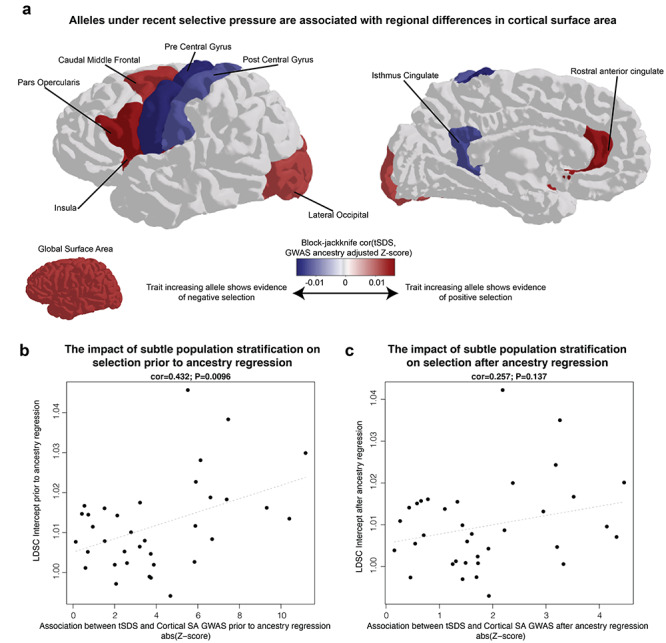
Evidence for haplotypes under recent polygenic selection (~2000–3000 years) impacting cortical structure. (a) A block-jackknife correlation of ancestry regressed effect sizes from GWAS (Z-scores) with scores of recent selection (tSDS) demonstrates evidence for polygenic alleles under selective pressure also influencing both global and regional SAs (colored regions indicate FDR < 0.05). Colder colors indicate that the trait increasing alleles (associated with increased SA) are generally associated with negative selection (decreasing allele frequencies in the population), whereas warmer colors indicate that trait increasing alleles are associated with positive selection. (b) Subtle population stratification, measured via LD-score regression (LDSC) intercept, is associated with stronger evidence of selection prior to ancestry regression. (c) Ancestry regression reduces the relationship between measures of selection and population stratification.